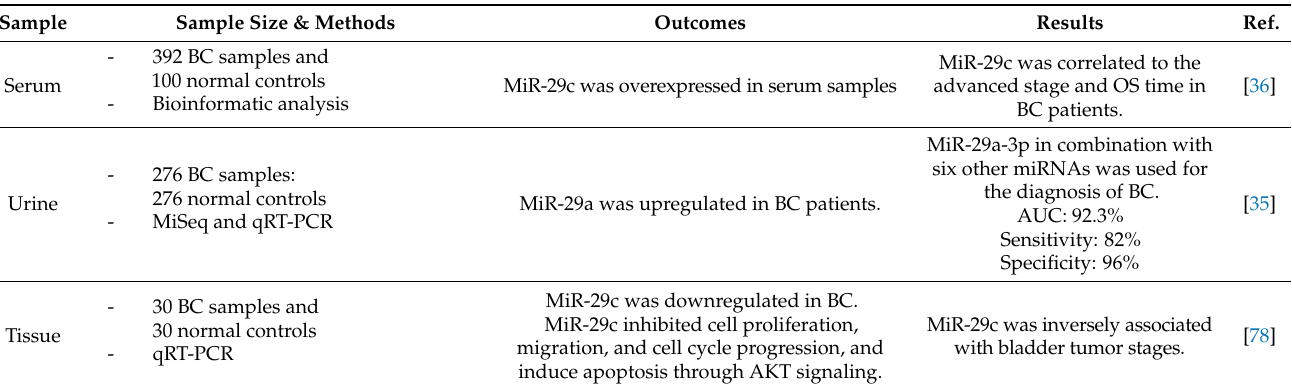
Table 2. miR-29s as biomarkers in bladder